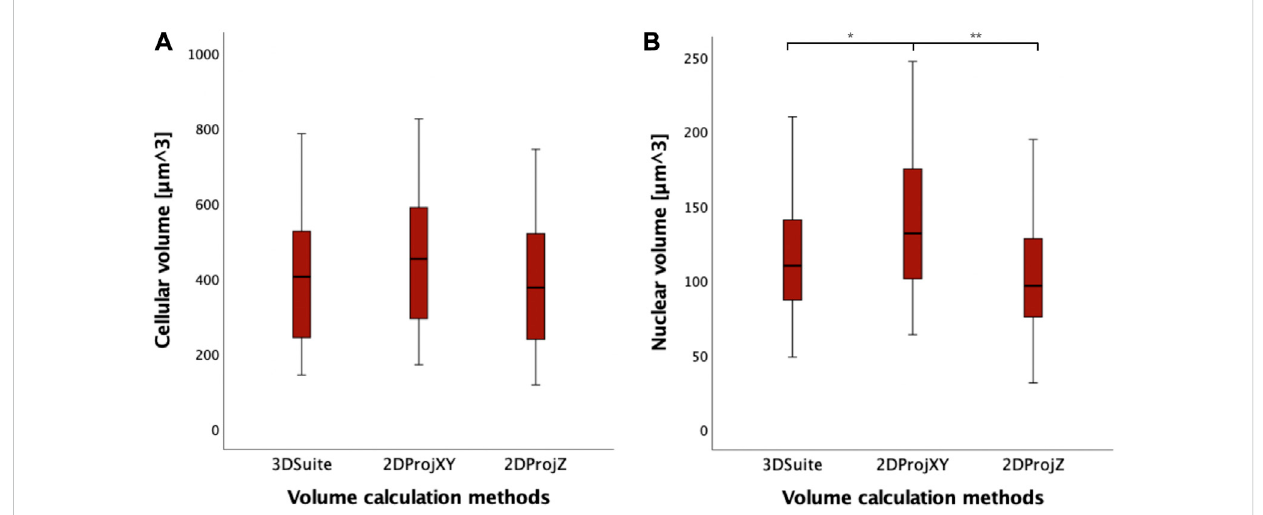
FIGURE 7 (A) Boxplots of cell volumes expressed in µm 3 , calculated with different methods (3DSuite, 2DProjXY, and 2DProjZ). (B) boxplot of nucleus volumes expressed in µm 3 , calculated with different methods (3DSuite, 2DProjXY, and 2DProjZ). The symbol * represents a statistically signi fi cant difference (* p < 0.05; ** p < 0.01; *** p <